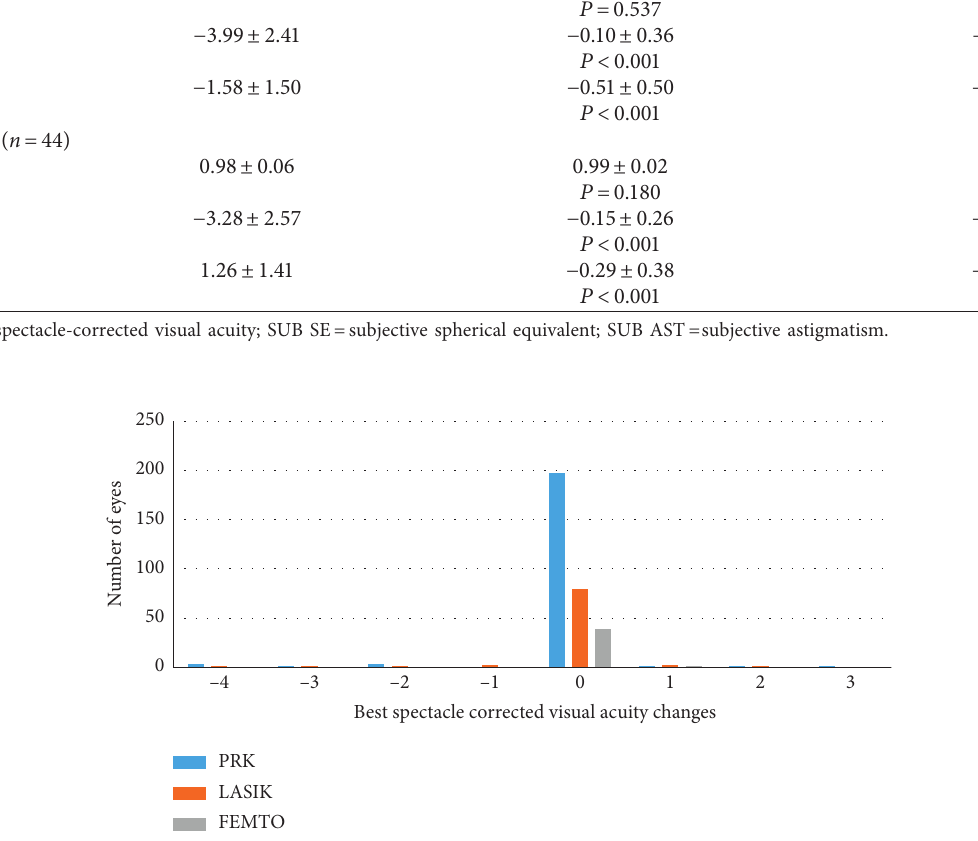
Figure 1: Postoperative losses and gains of the best spectacle corrected visual acuity (BSCVA)